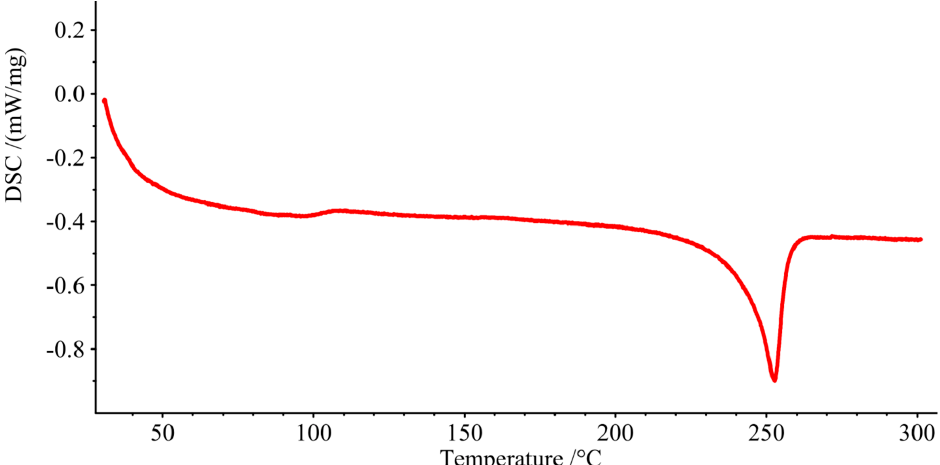
Figure 10. DSC curve of shredded water bottle.